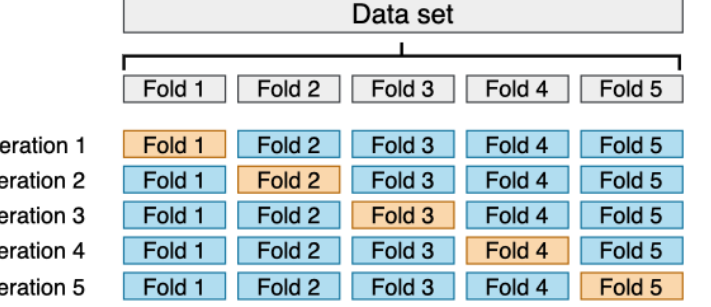
Figure 8. K-fold validation (k = 5) employed to evaluate the performance of the classification algo-